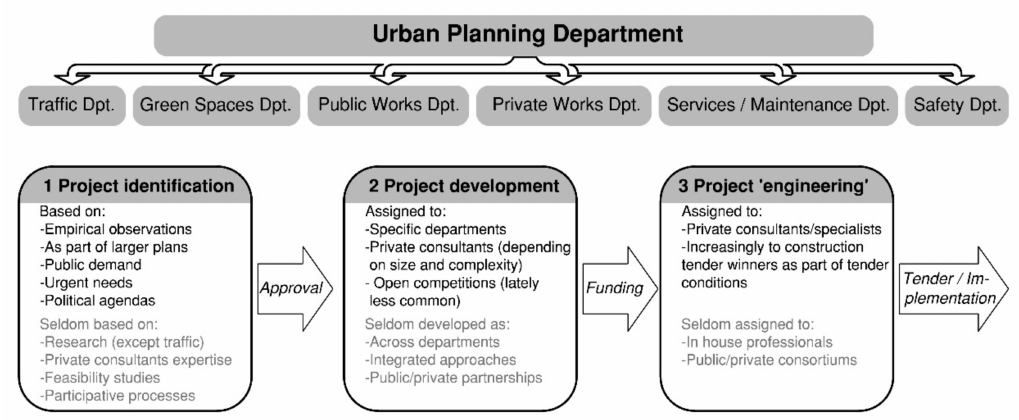
Figure 5. Three main stages of regulatory planning are typically assigned to specific departments. The many variables make it difficult, if not impossible, to expect a resulting integrated